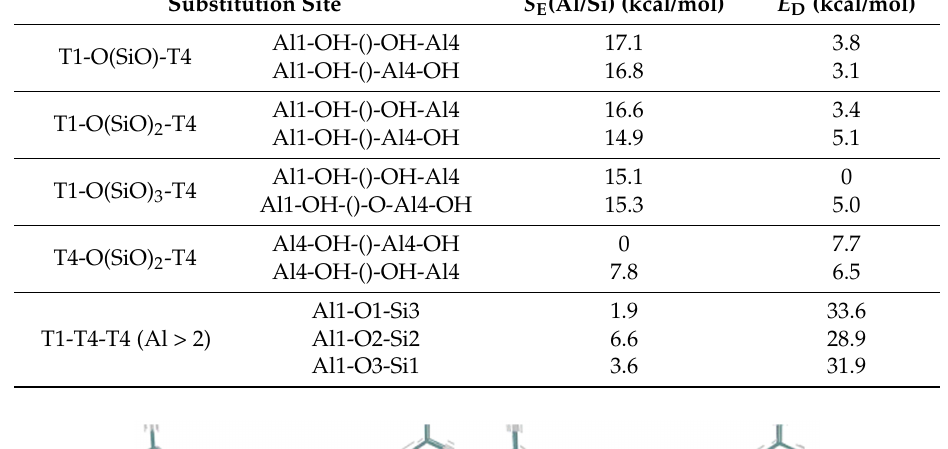
Table 2. Characterization of stability and acid strength of Brönsted acid sites calculated on n ‐ Al models ( n ≥ 2).